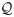
Comparison between the initial (orange) and final (purple) convex hull of the rescaled metabolic strategies (colored dots) when they are allowed to adapt according to (4).These results have been obtained for a system with m = 10 species and p = 3 resources using the graphical representation method introduced by Posfai et al. [10] and using a common value of the CTR Q for all species. In particular, in this case this method prescribes that the rescaled metabolic strategies and nutrient supply rate vector (black star) all lie on a 2-dimensional simplex (i.e. the triangle in the figure), where each vertex corresponds to one of the resources; for details on the parameters used, and for the plots of the temporal dynamics of the population densities and metabolic strategies, see Figure D in S1 Text. In the final state, the α^→σ have incorporated s^→ in their convex hull.